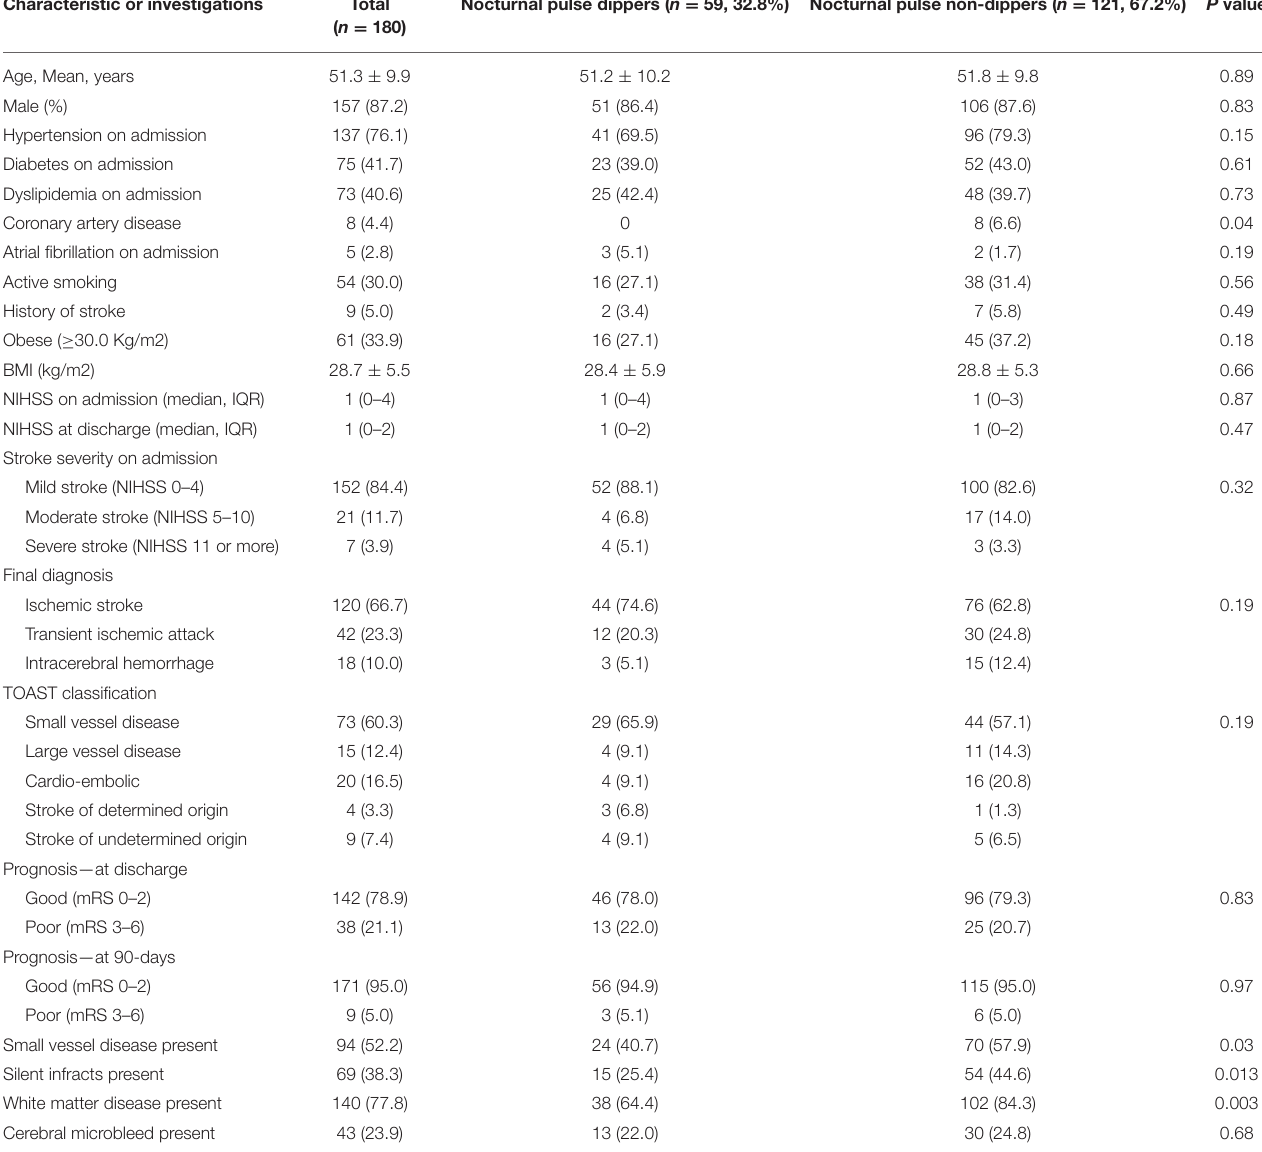
TABLE 3 | Demographics, clinical features, and imaging characteristics of the patients with and without nocturnal pulse dipping. Characteristic or